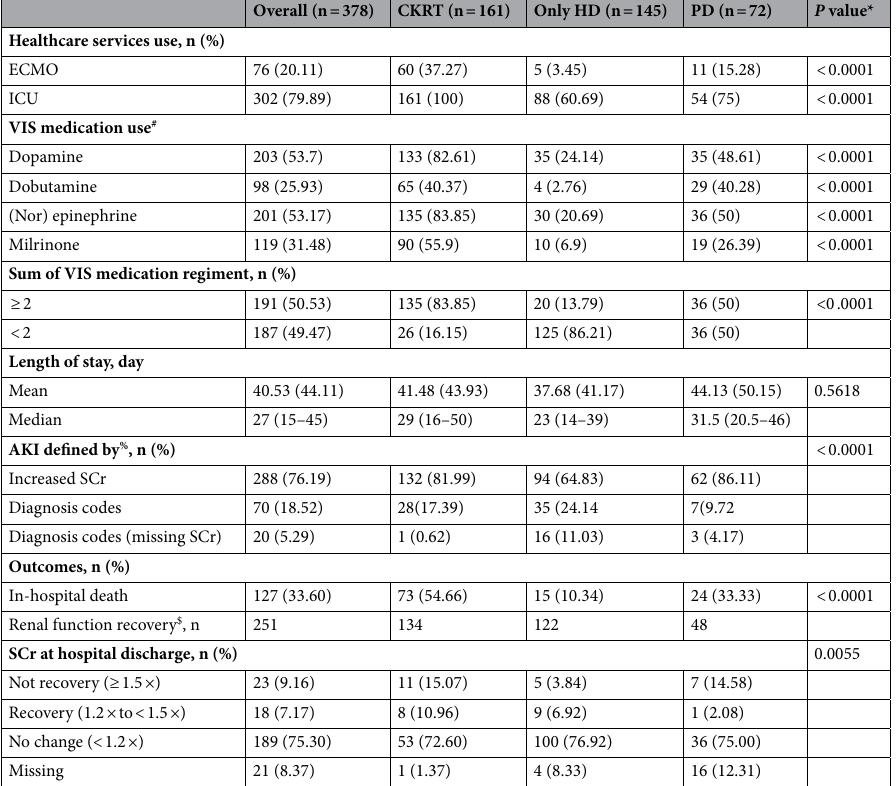
Table 2. Healthcare services use and in-hospital outcomes. CKRT continuous kidney replacement therapy, HD hemodialysis, PD peritoneal dialysis, ECMO extracorporeal membrane oxygenation, ICU intensive